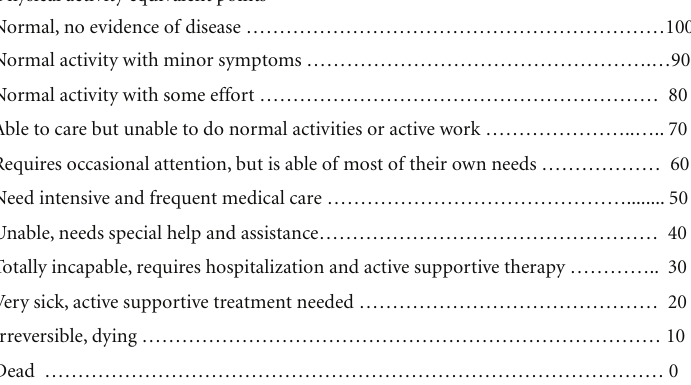
Figure 1: Karnofsky scale